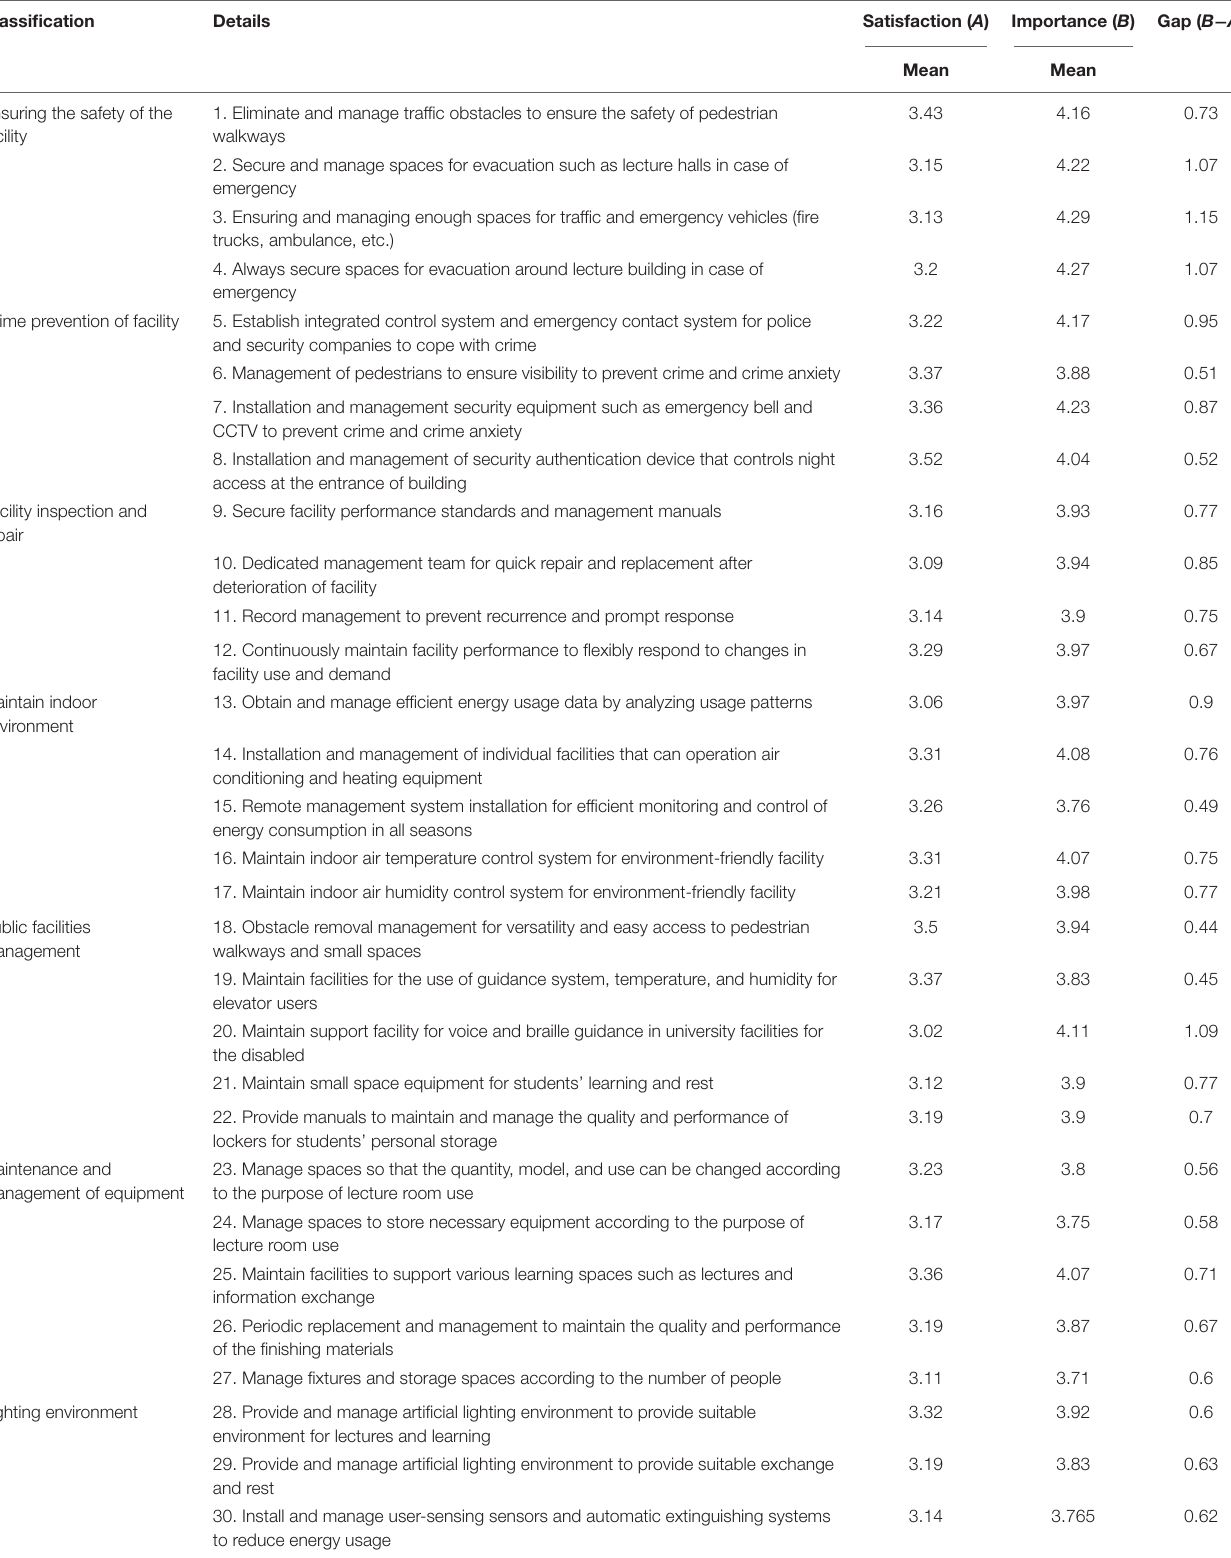
TABLE 2 | Classification and items of UFM. Classification